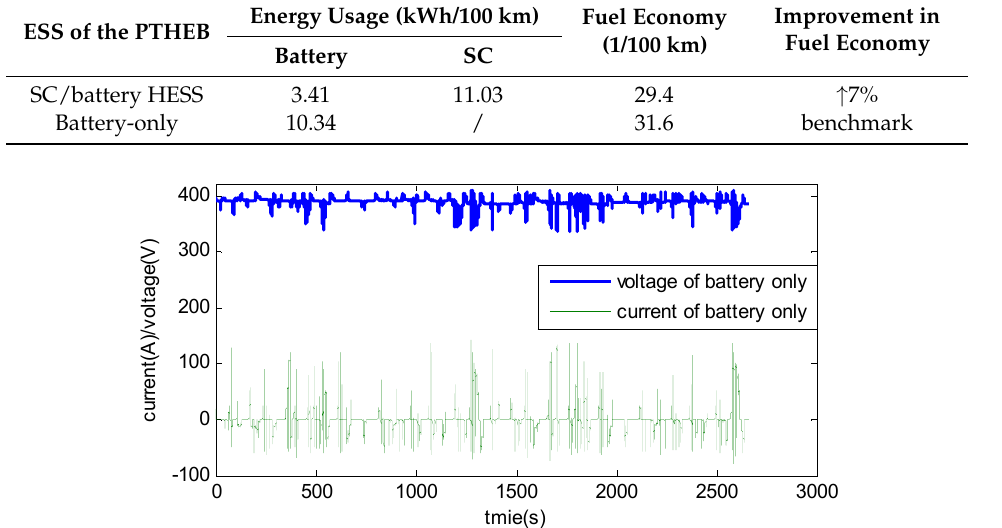
Table 10. The results of PTHEB with HESS/battery-only.